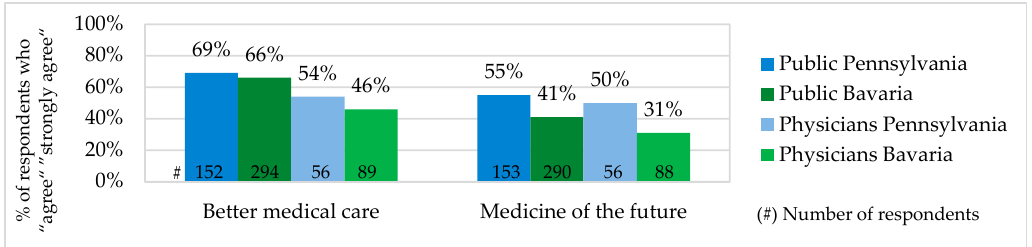
Figure 2. Personalized Medicine Acceptance.